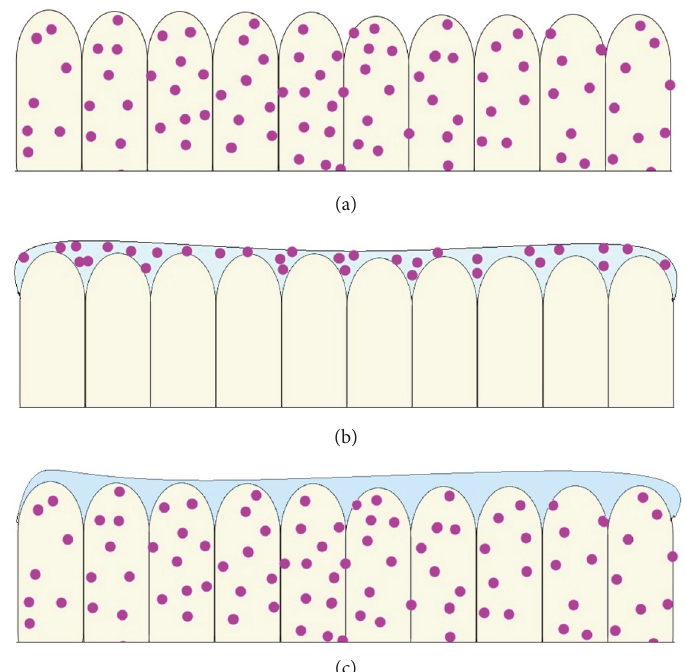
Figure 5: Types of membranes with nanoparticles added [13]: (a) typical nanocomposite membrane; (b) TFN membrane with nanoparticles in the skin layer; (c) TFN membrane with nanoparticles in the